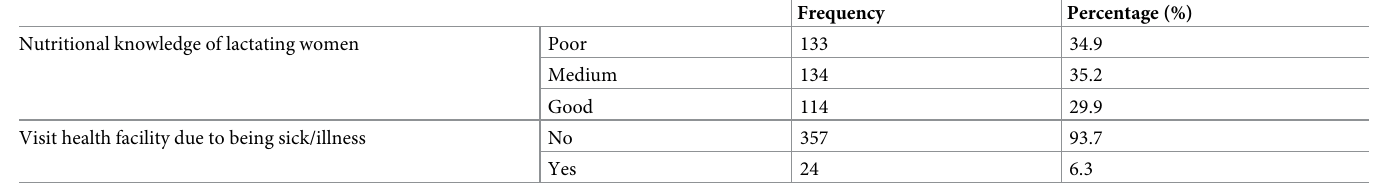
Table 2. Nutritional knowledge and health status of lactating women in Bahir Dar city, Northwest Ethiopia, 2021(n = 381).